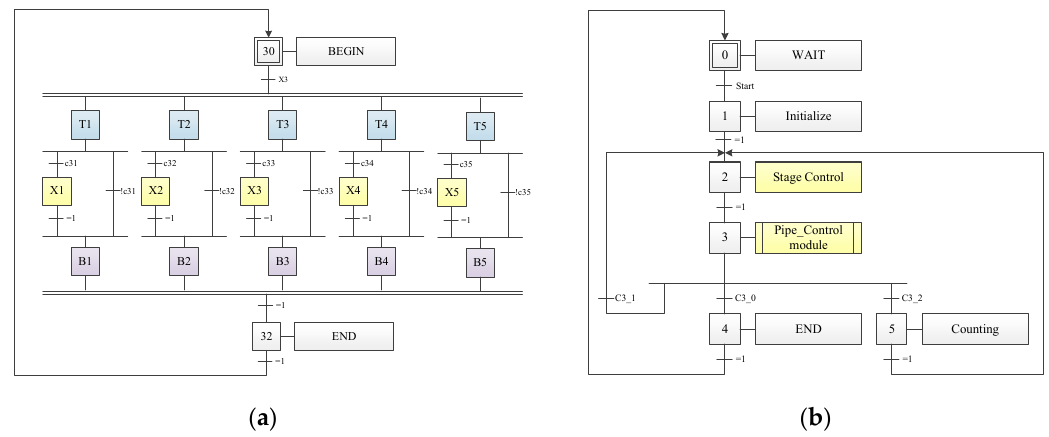
Figure 14. Discrete-event model of the pipeline controller. ( a ) Stage controller. ( b ) Top controller.